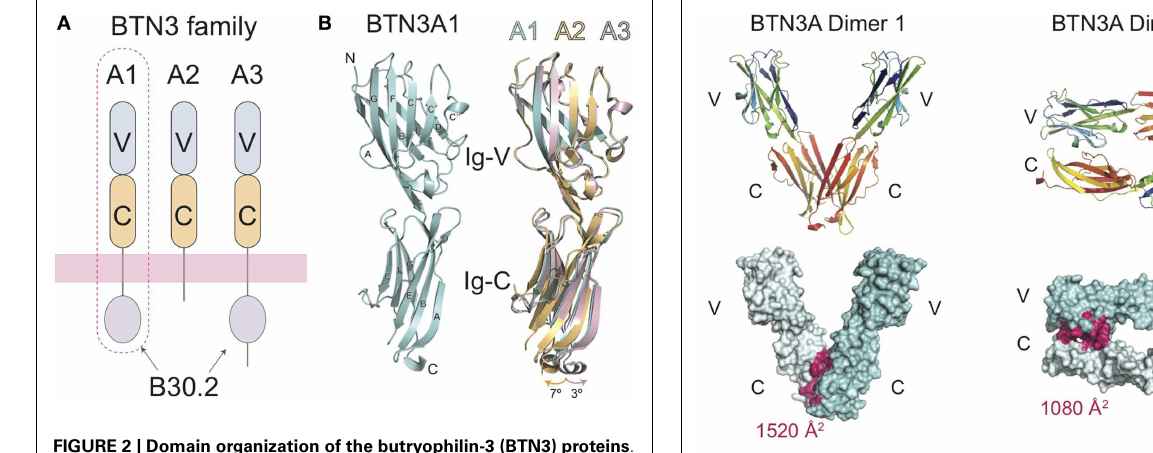
FIGURE 2 | Domain organization of the butryophilin-3 (BTN3) proteins . (A) The BTN3A extracellular domains are members of the B7-superfamily with a membrane-proximal IgC domain and an N-terminal IgV domain.The extracellular domains between the three isoforms are highly similar, but are linked, via a single-pass transmembrane region, to intracellular domains that vary amongst the three BTN3A family members. BTN3A1 and BTN3A3 both contain intracellular B30.2 domains whereas BTN3A2 does not. BTN3A1, circled with a dotted line, has been shown to be necessary for pAg-induced activation ofV γ 9V δ 2T cells. (B) The three-dimensional structures of the extracellular domain of BTN3A1 is shown in cyan (left) and superimposed with the A2 and A3 isoforms (right) shown in gold and pink, respectively.The structures are highly homologous, with only small variations in the hinge angles between the IgV and Ig-C domains.